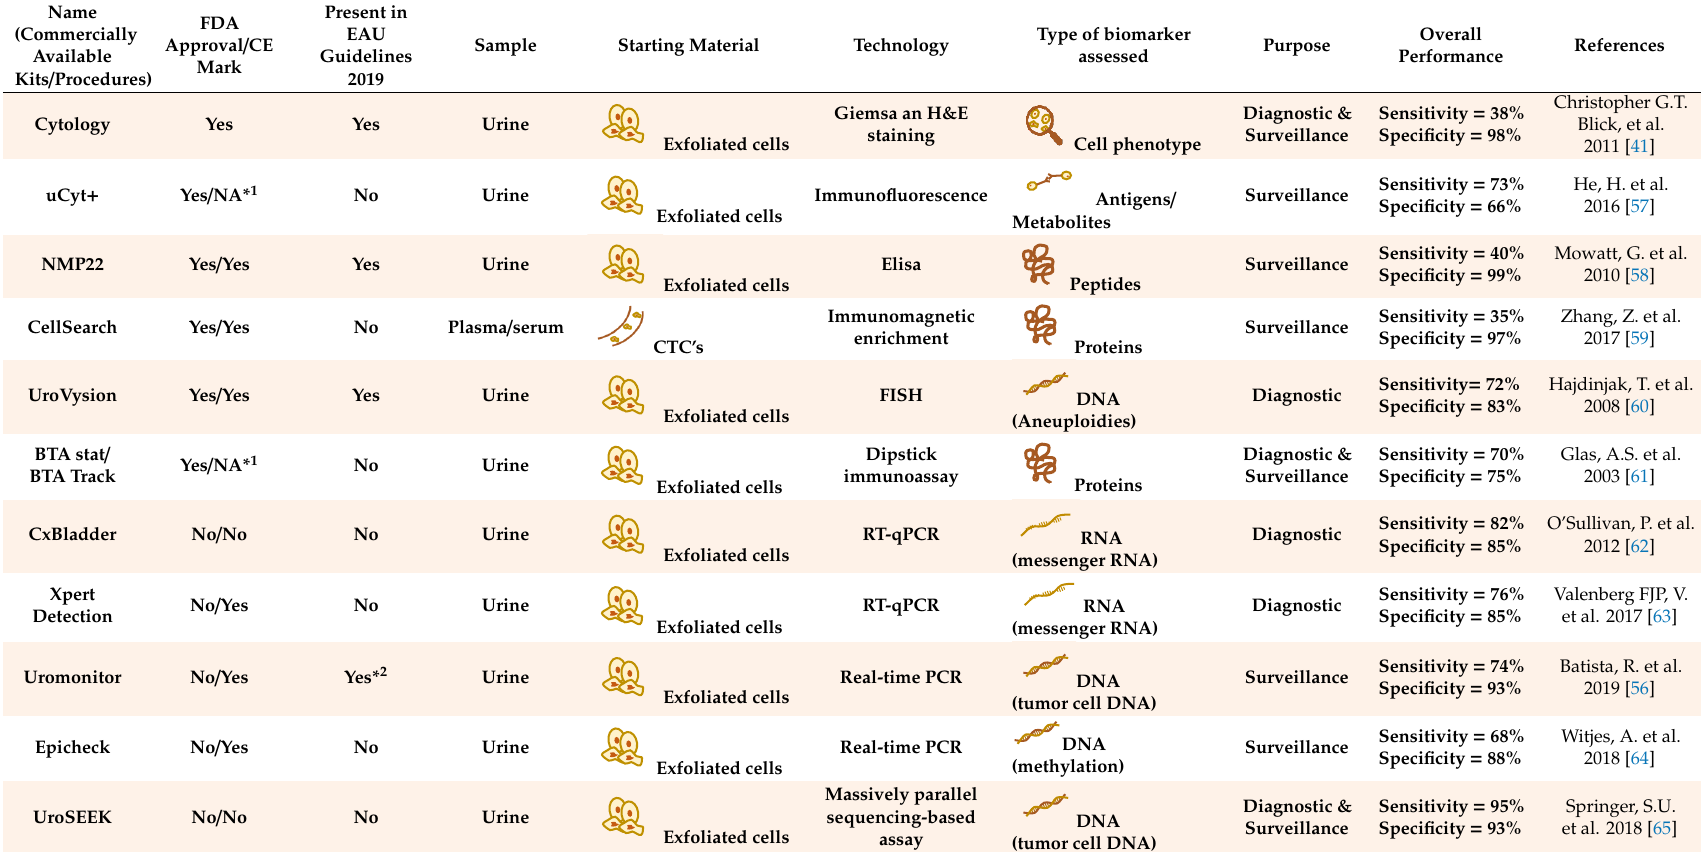
Table 1. Available commercial kits performance and characteristics.